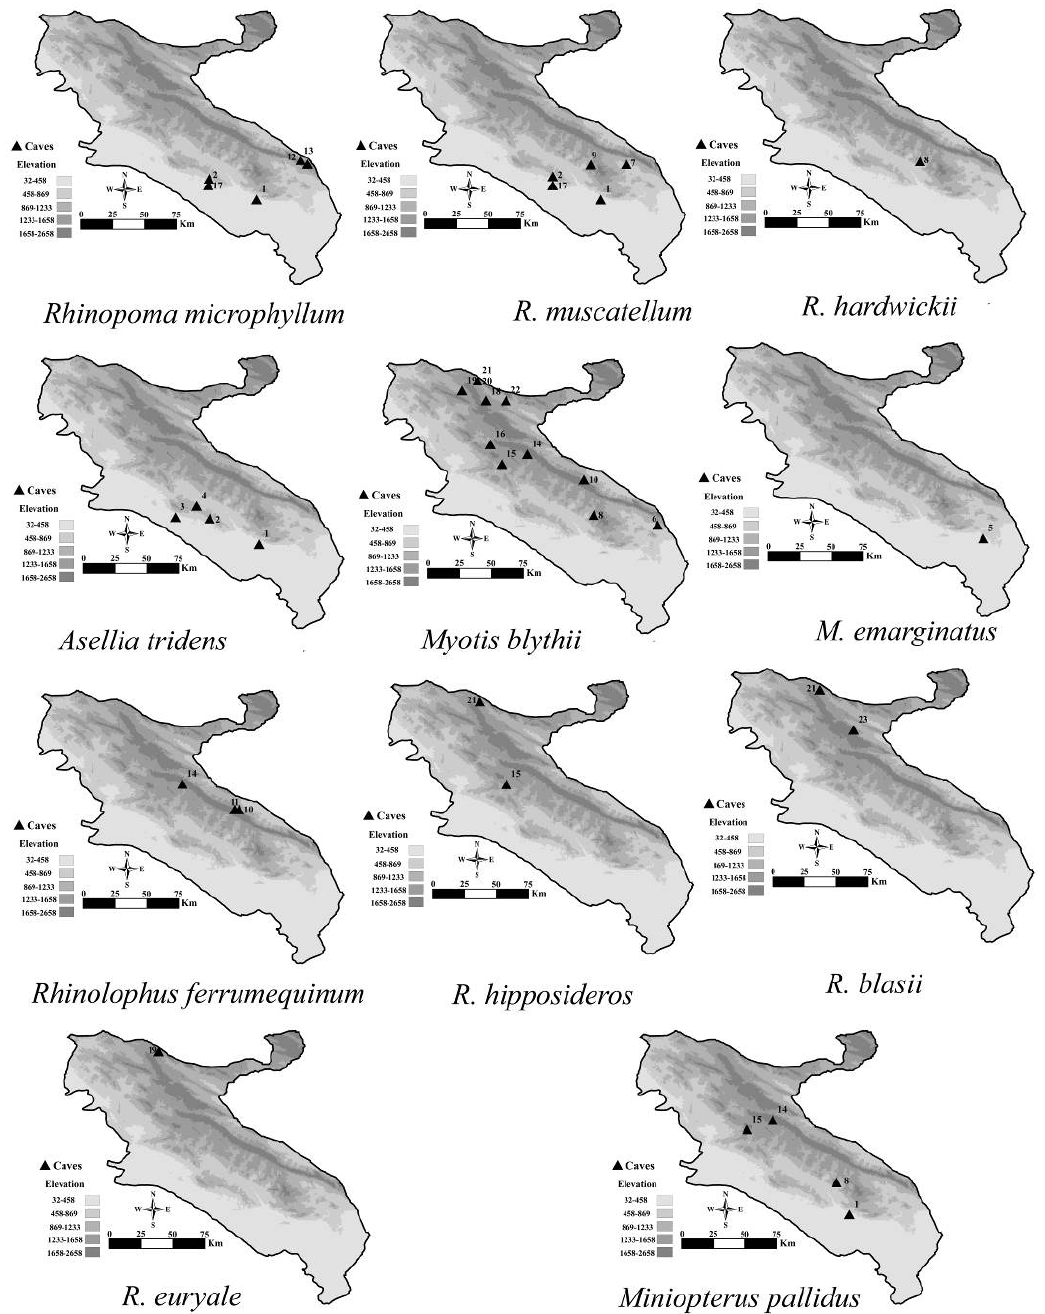
F IGURE 2. Map of records of all